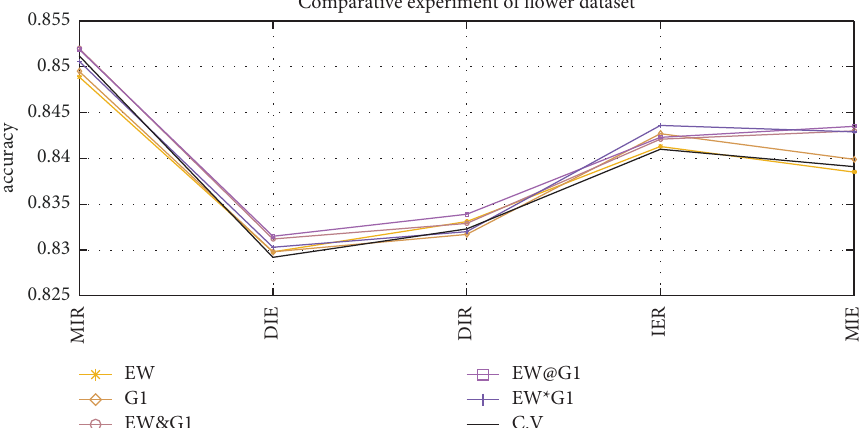
Figure 7: Comparative experiment of the fower data set.